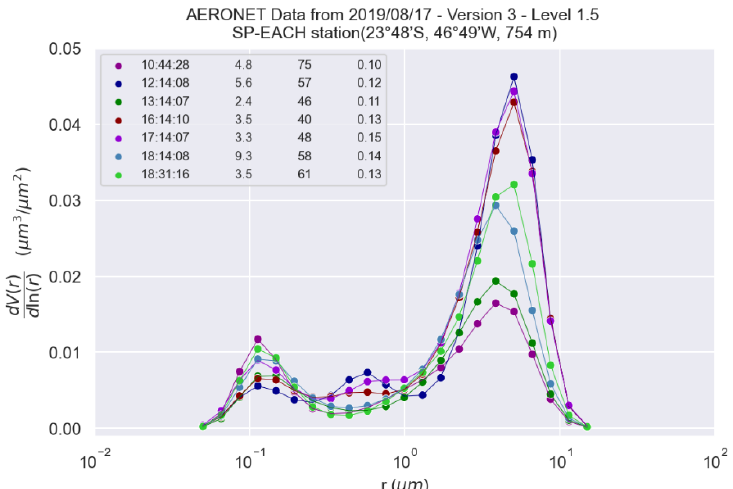
Figure 12. Aerosol size distribution was retrieved from AERONET sunphotometer measurements at the EACH station in São Paulo city (23°48 ′ S, 46°49 ′ W, 754 m asl) on 17 August 2019. Solid circle-lines numbers in the legend (top-left) indicate local time, particle radius (µm), number, and volume density (µm 3 µm −2 ). 𝑑𝑉(𝑟) 𝑑𝑙𝑛(𝑟)⁄ is the particle volume density and 𝑟 is the particle radius. According to Cazorla et al., 2012 [45], the chemical composition of aerosol can be identified from the Ångström Matrix. It consists of a dispersion diagram of Scattering Ångström Exponent (SAE) by Absorption Ångström Exponent (AAE). The sub-sections of this diagram define aerosol composition by grouping absorbing aerosol types [46,47].